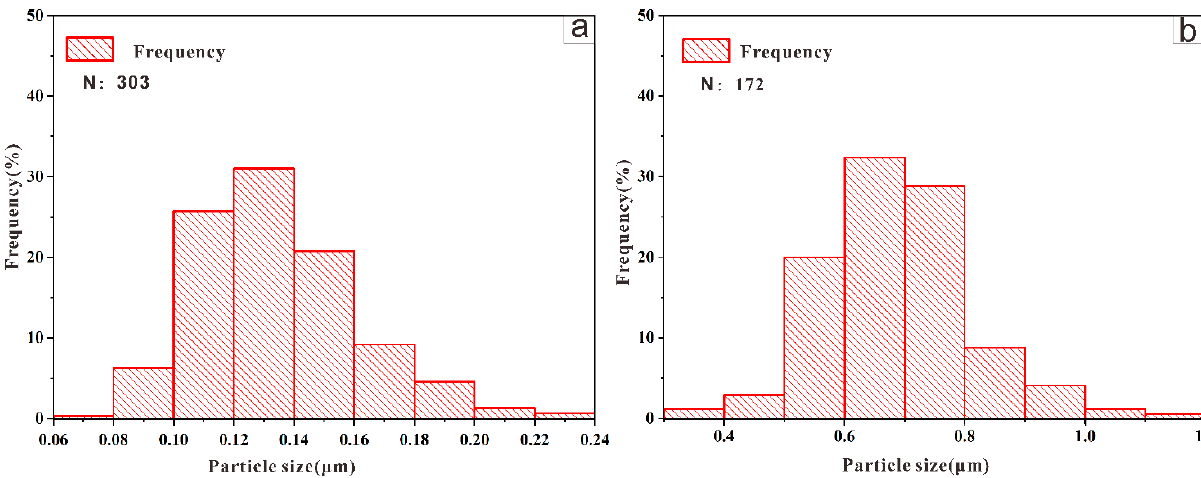
Figure 4. Scanning electron microscope (SEM ) images of barite synthesized with a mixed solution of 0.03 mol/kg Na 2 SO 4 and BaCl 2 ( a ) and a mixed solution of 0.1 mol/kg Na 2 SO 4 and BaCl 2 ( b ) with a ratio of 1:1 at room temperature.